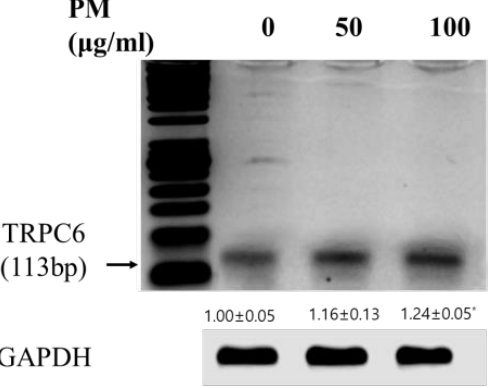
Figure 8. Determination of the TRPC6 mRNA expression in RAW 264.7 cells. Data are expressed as mean ± standard deviation (SD) of 3 independent experiments ( n ≥ 3). The mRNA band intensities were converted to the numerical data using Image-Studio software (LI COR, Lincoln, NE, USA). One-way ANOVA was used for comparison of group means, followed by Dunnett’s t-test (* p < 0.05 vs. untreated control).